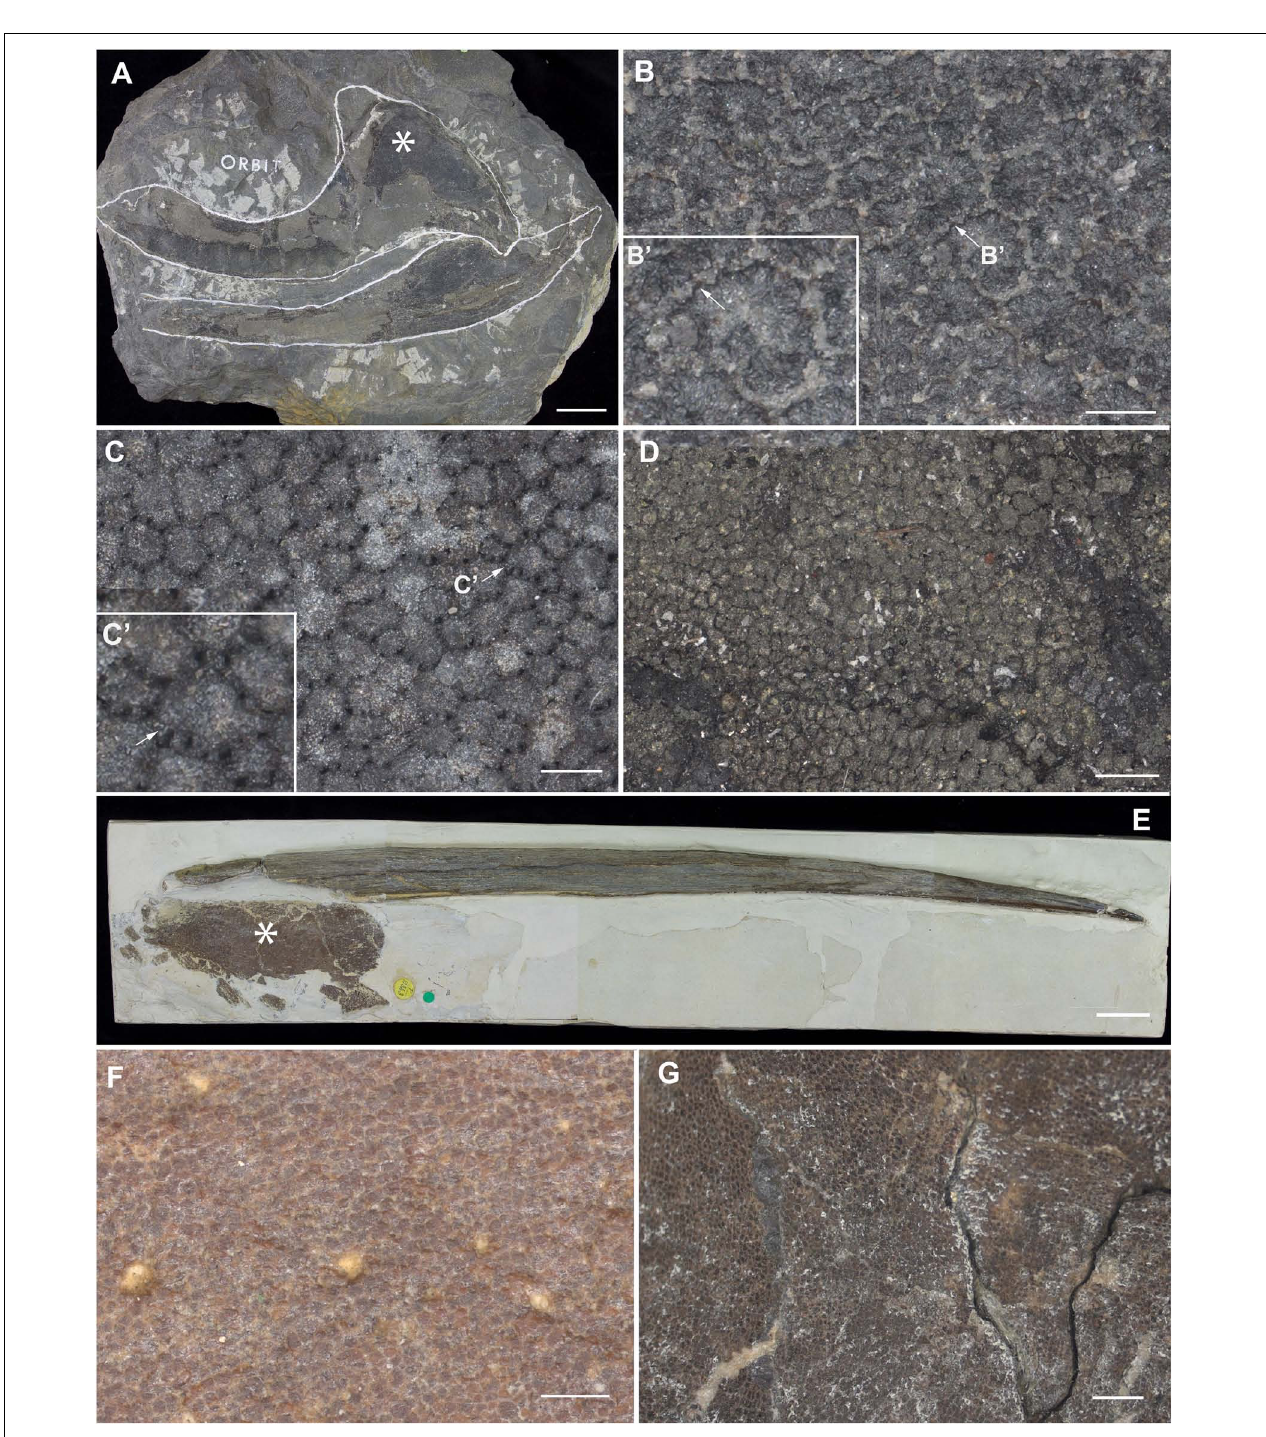
FIGURE 9 | Mineralized cartilage in stem Holocephali and crown group Holocephali ( Figure 8 ). (A) NHMUK PV P.9285, Cladoselache , stem Holocephali, palatoquadrate, and Meckel’s cartilage; asterisk indicates area shown in (B) , anterior to the left; (B) polygonal mineralization (tesserae), with irregular margins; (B’) closeup of tessera, white arrow indicates contact along the tesseral margin which may represent “spokes” characterizing elasmobranch tesserae; (C) NHMUK PV P.62281a, Cobelodus , stem Holocephali, cranium, more regular polygonal mineralization (tesserae); (C’) closeup of tessera, white arrow indicates “spokes” more similar to those in elasmobranch tesserae; (D) NHMUK PV P.62316b, Sibirhynchus , stem Holocephali, cranium, polygonal mineralization (tesserae); (E,F) NHMUK PV P.10343, Edaphodon , Family Callorhinchidae, crown group Holocephali ( Figures 8 , 2 ), (E) dorsal fin endoskeletal support (with dorsal fin spine, anterior to left), asterisk indicates area shown in (F) , anterior to the left; (F) closeup showing polygonal mineralization (tesserae); (G) NHMUK PV P.8212, Helodus , cranium, polygonal mineralization. See Supplementary Info Table 1 for tessera sizes in these taxa.